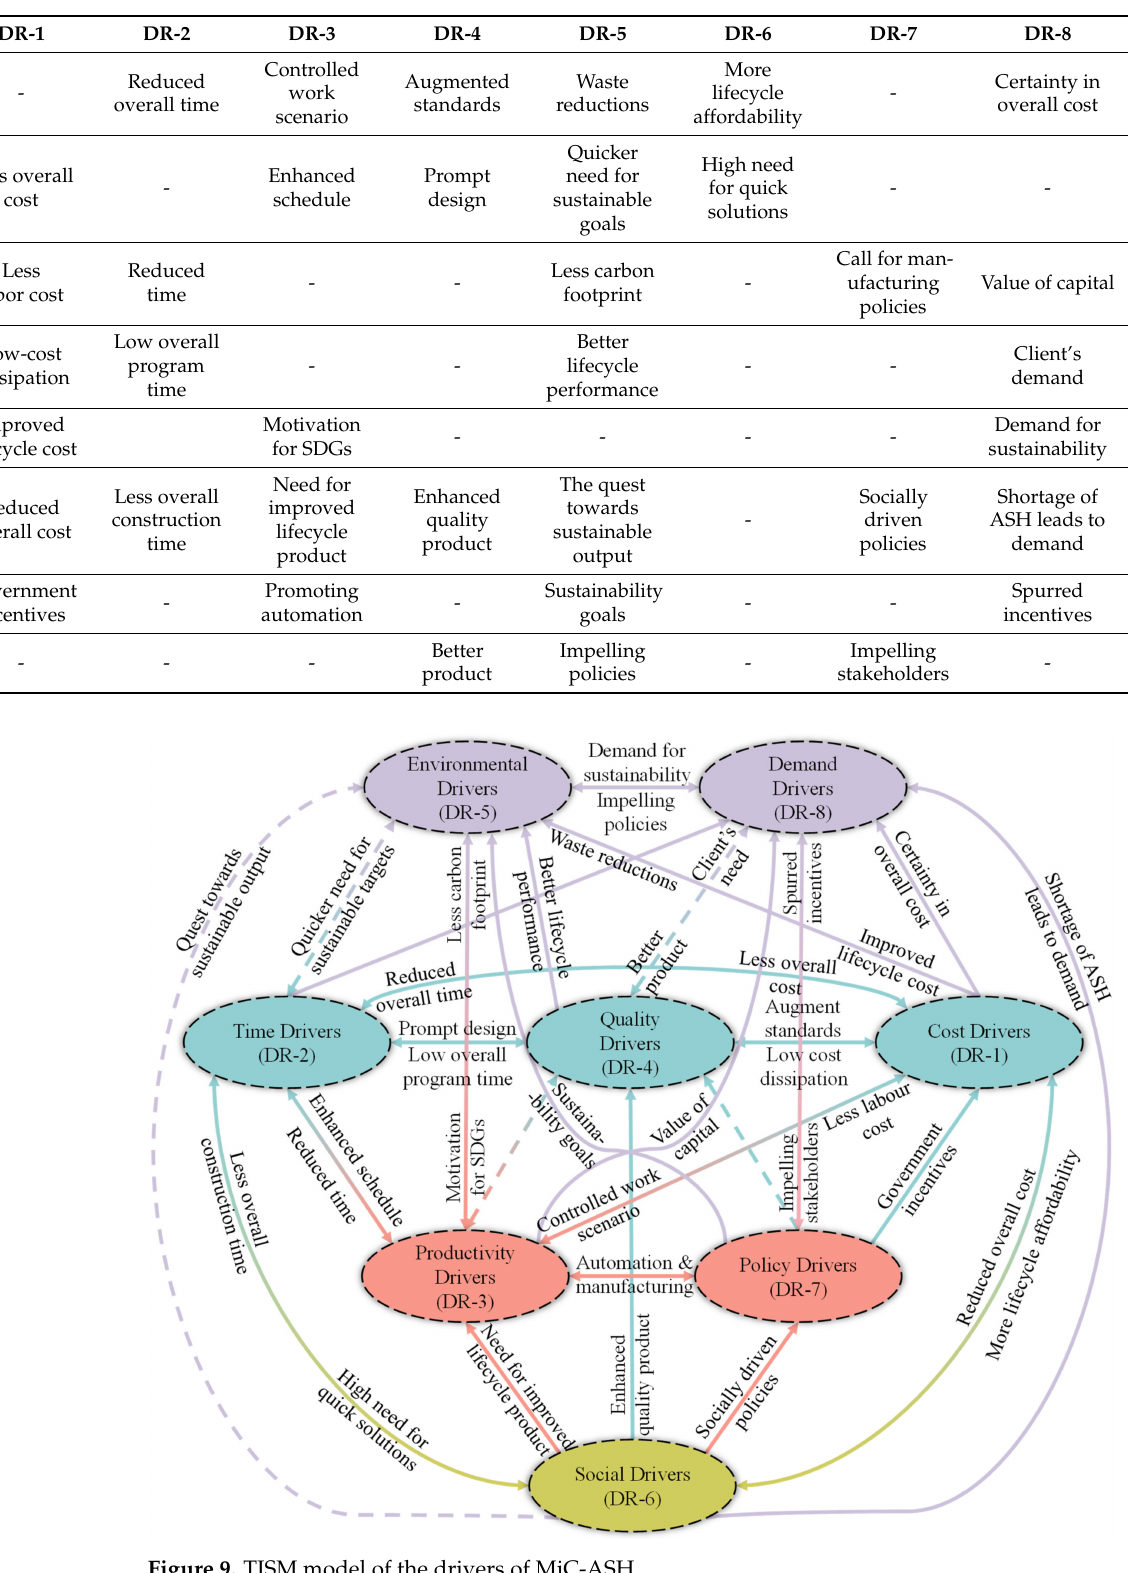
Figure 9. TISM model of the drivers of